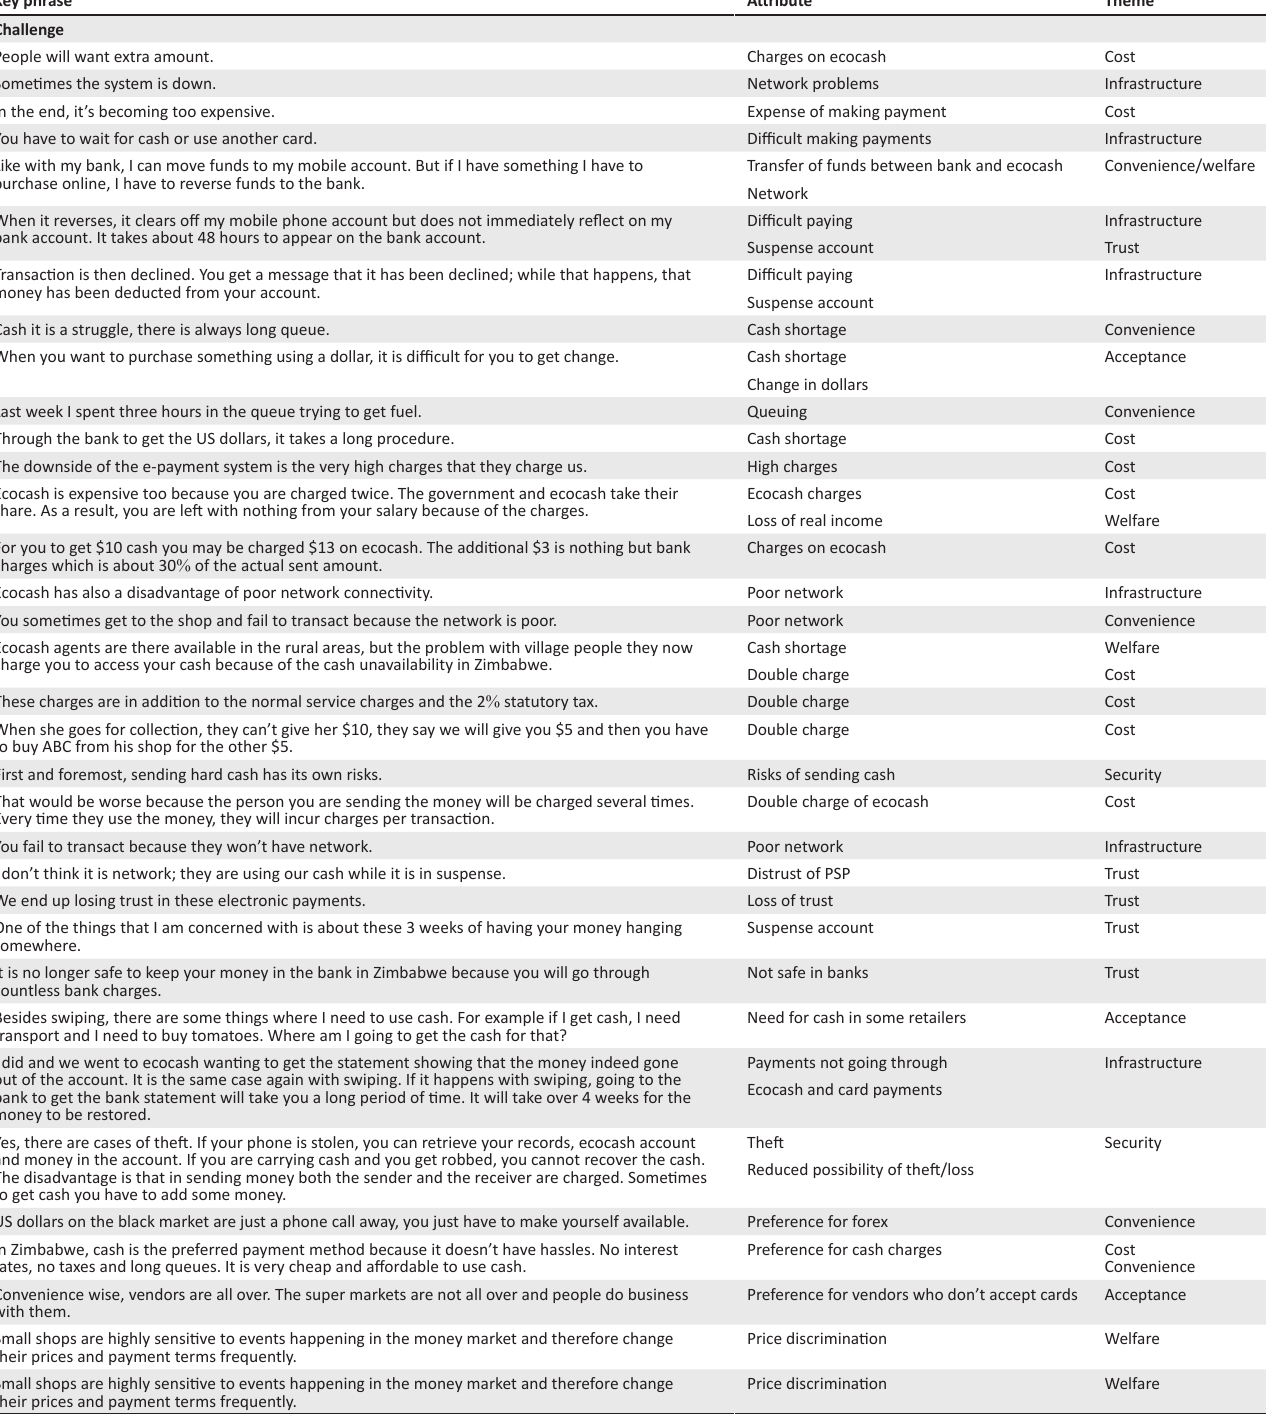
TABLE 1-A1: Sample coding. Key phrase Attribute Theme Challenge